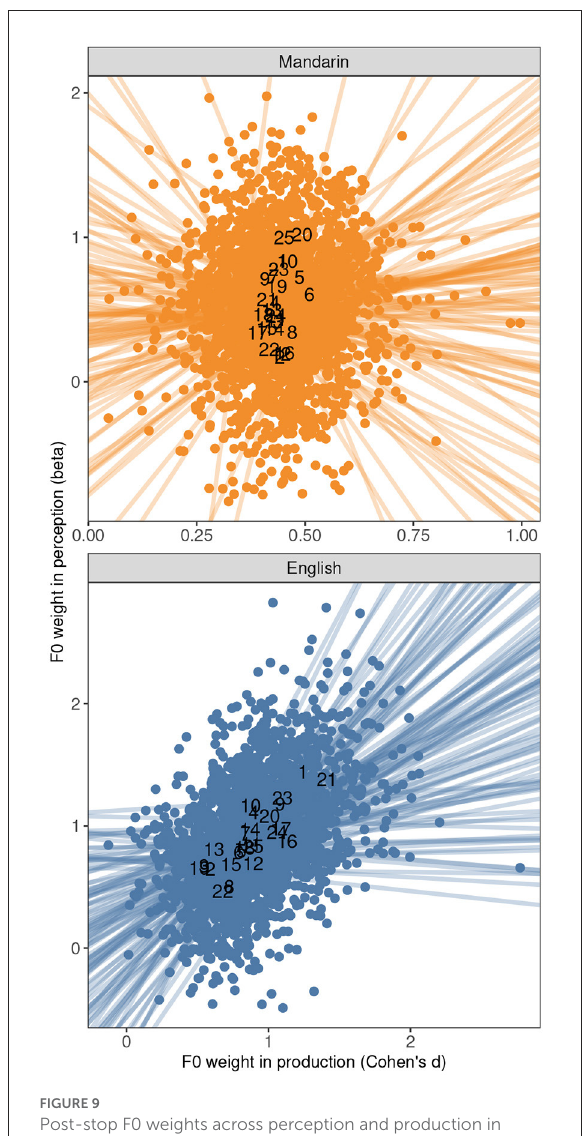
FIGURE9 Post-stop F0 weights across perception and production in Mandarin and English. The numbers represents the posterior means for individual participants. Each dot is a posterior draw for a participant. The solid lines represent 100 regression lines fitted with 100 posterior draws, to show the direction and uncertainty of the